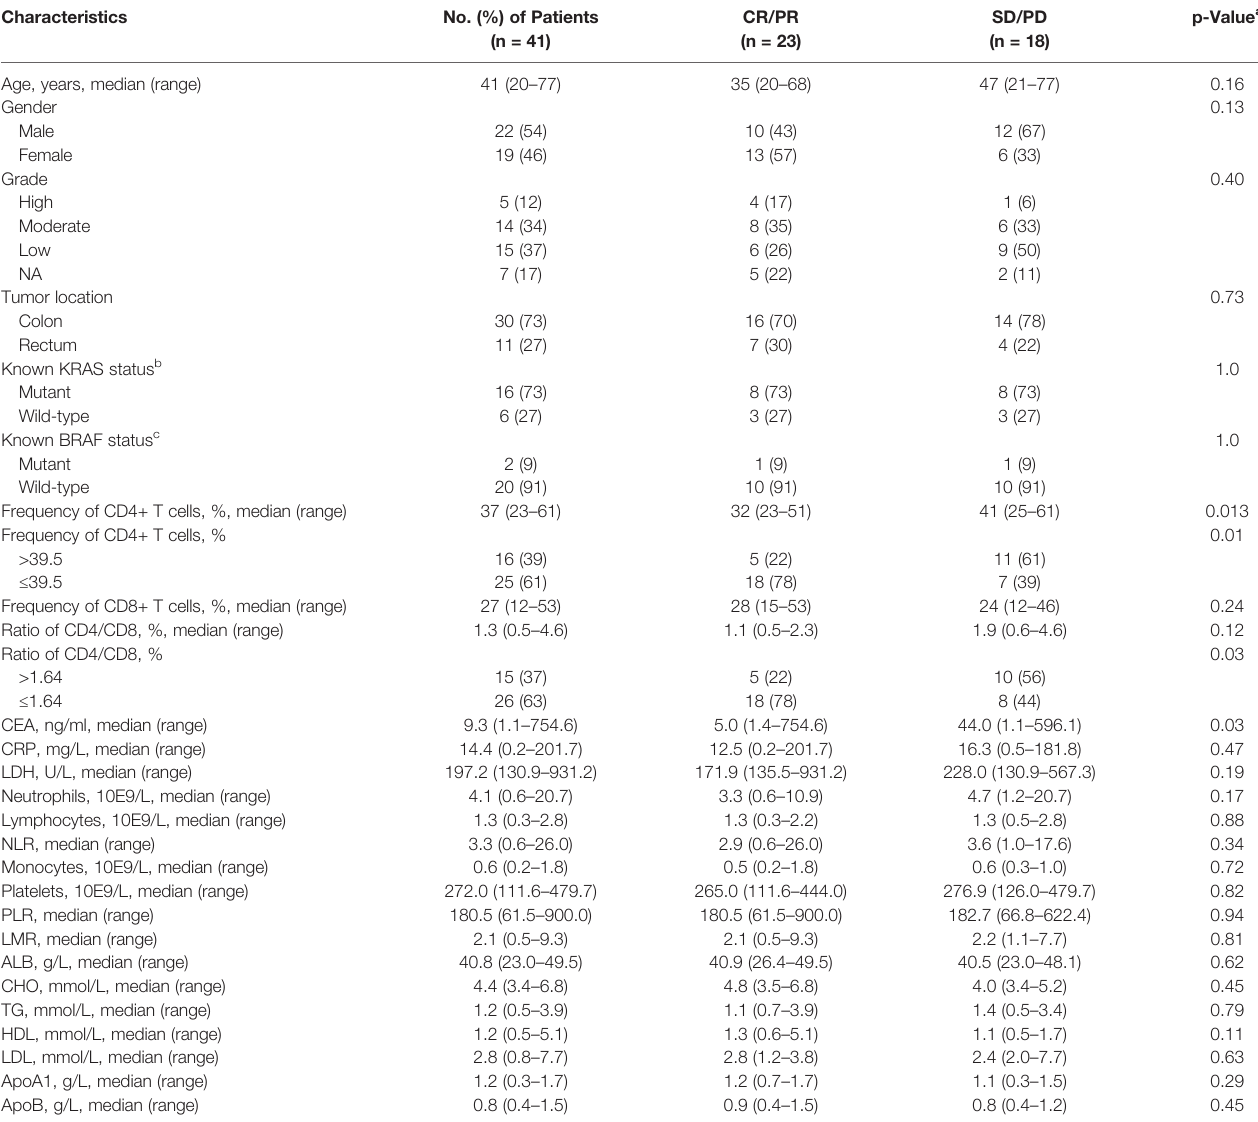
TABLE 1 | Patients ’